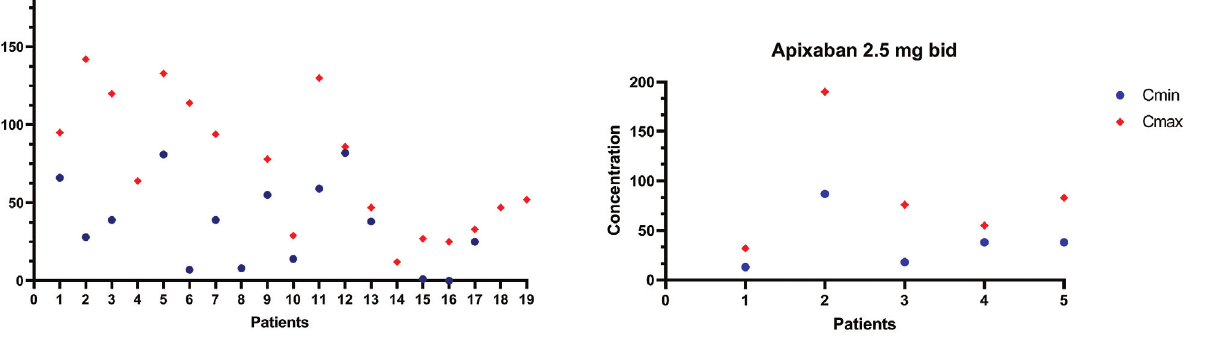
Fig. 2 Apixaban trough Cmin and Cmax levels (2hours after inges- tion) are shown for patients on Apixaban 2.5mg